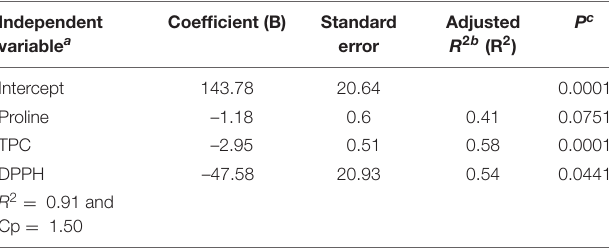
reducing power (IC50) as independent variables. b Calculated by linear regression analysis. c All variables left in the model are significant at the p < 0.1